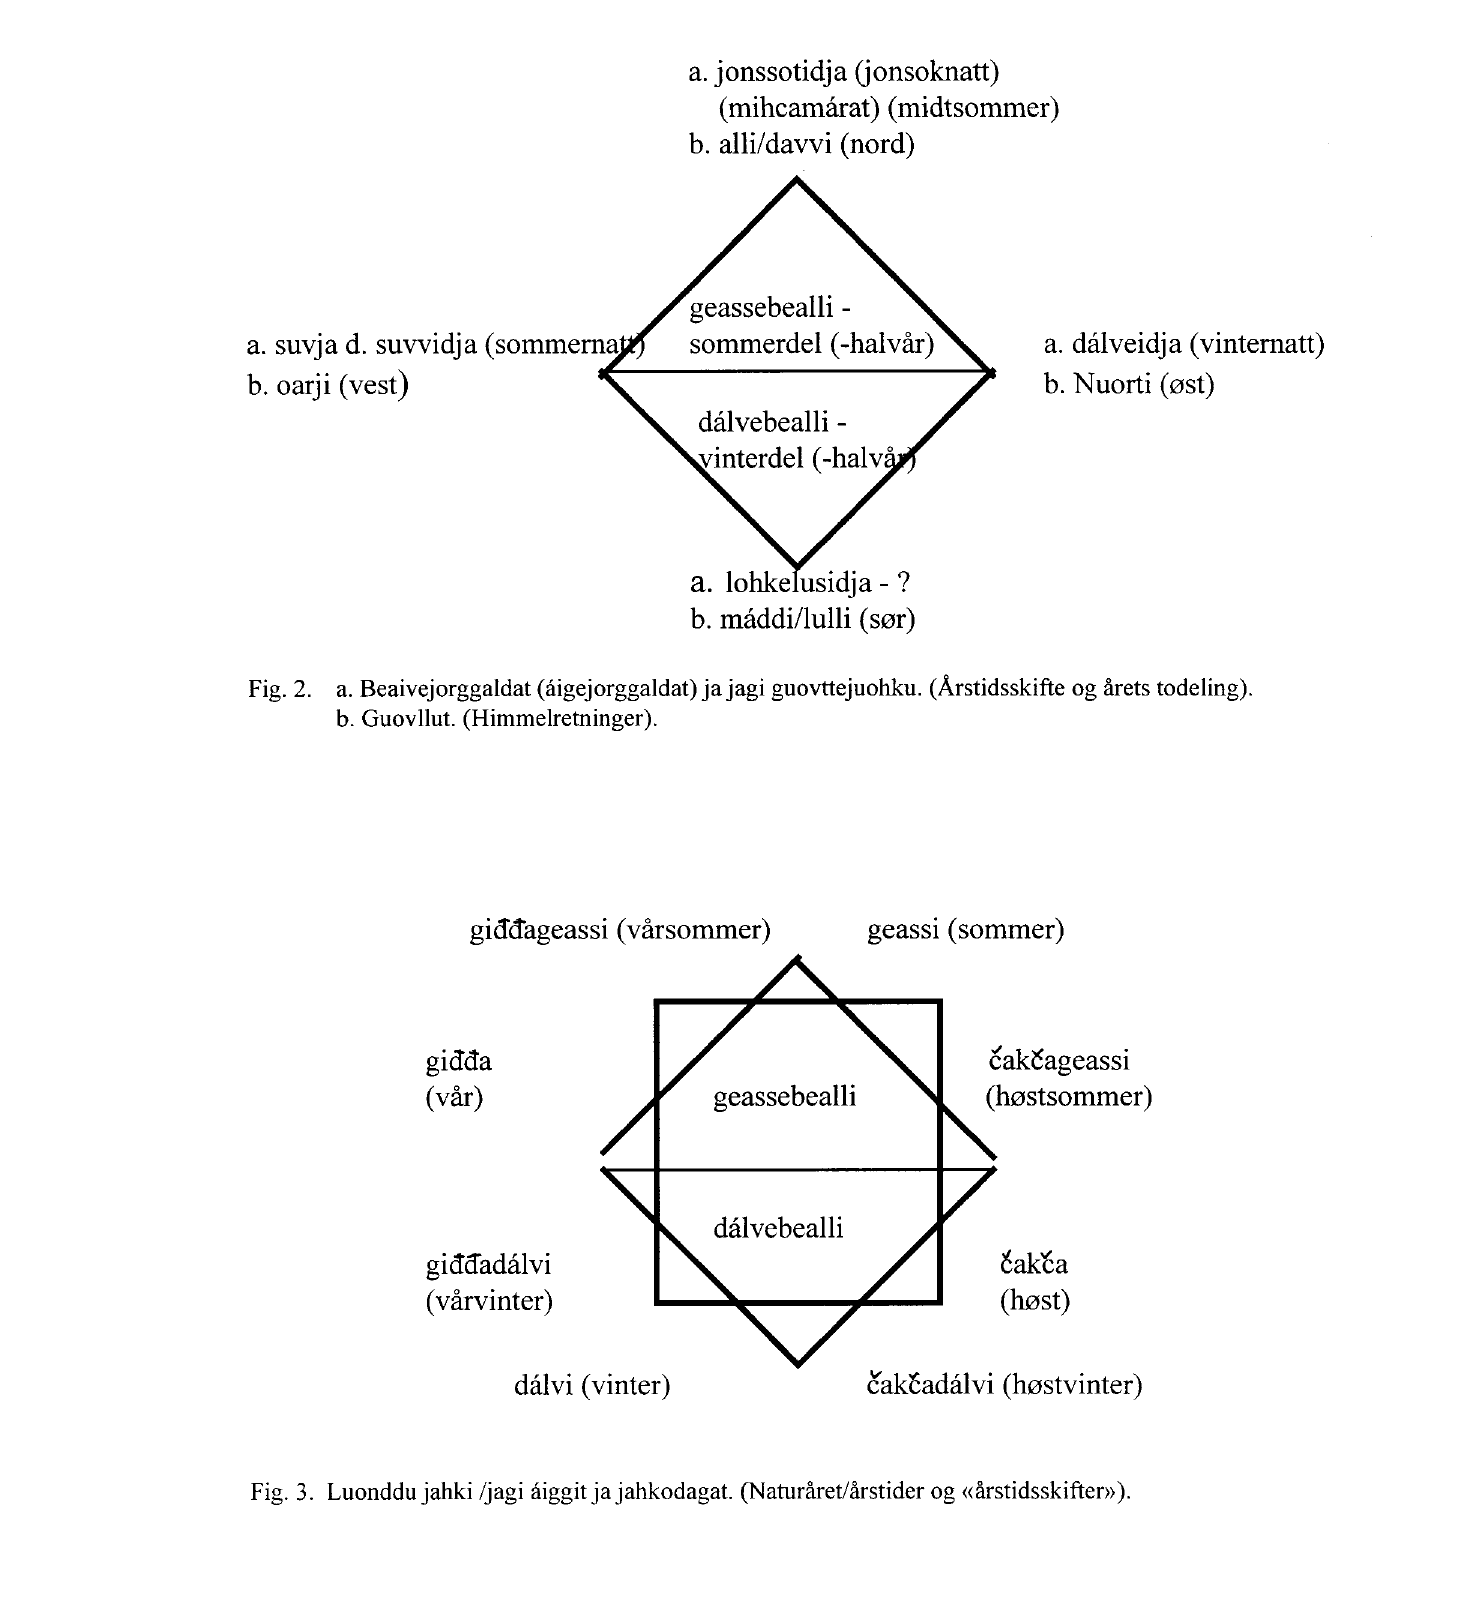
Fig. 3. Luonddu jahki /jagi åiggit ja jahkodagat. (Naturåret/årstider og